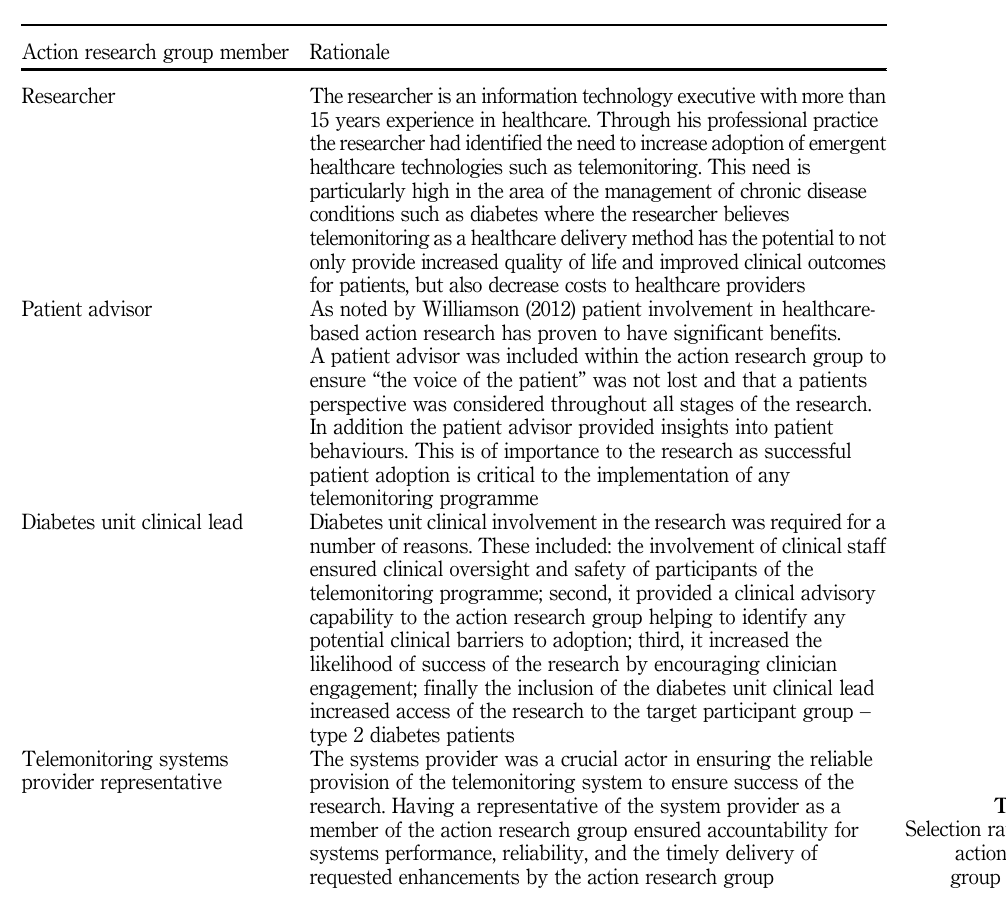
Figure 4. Action research